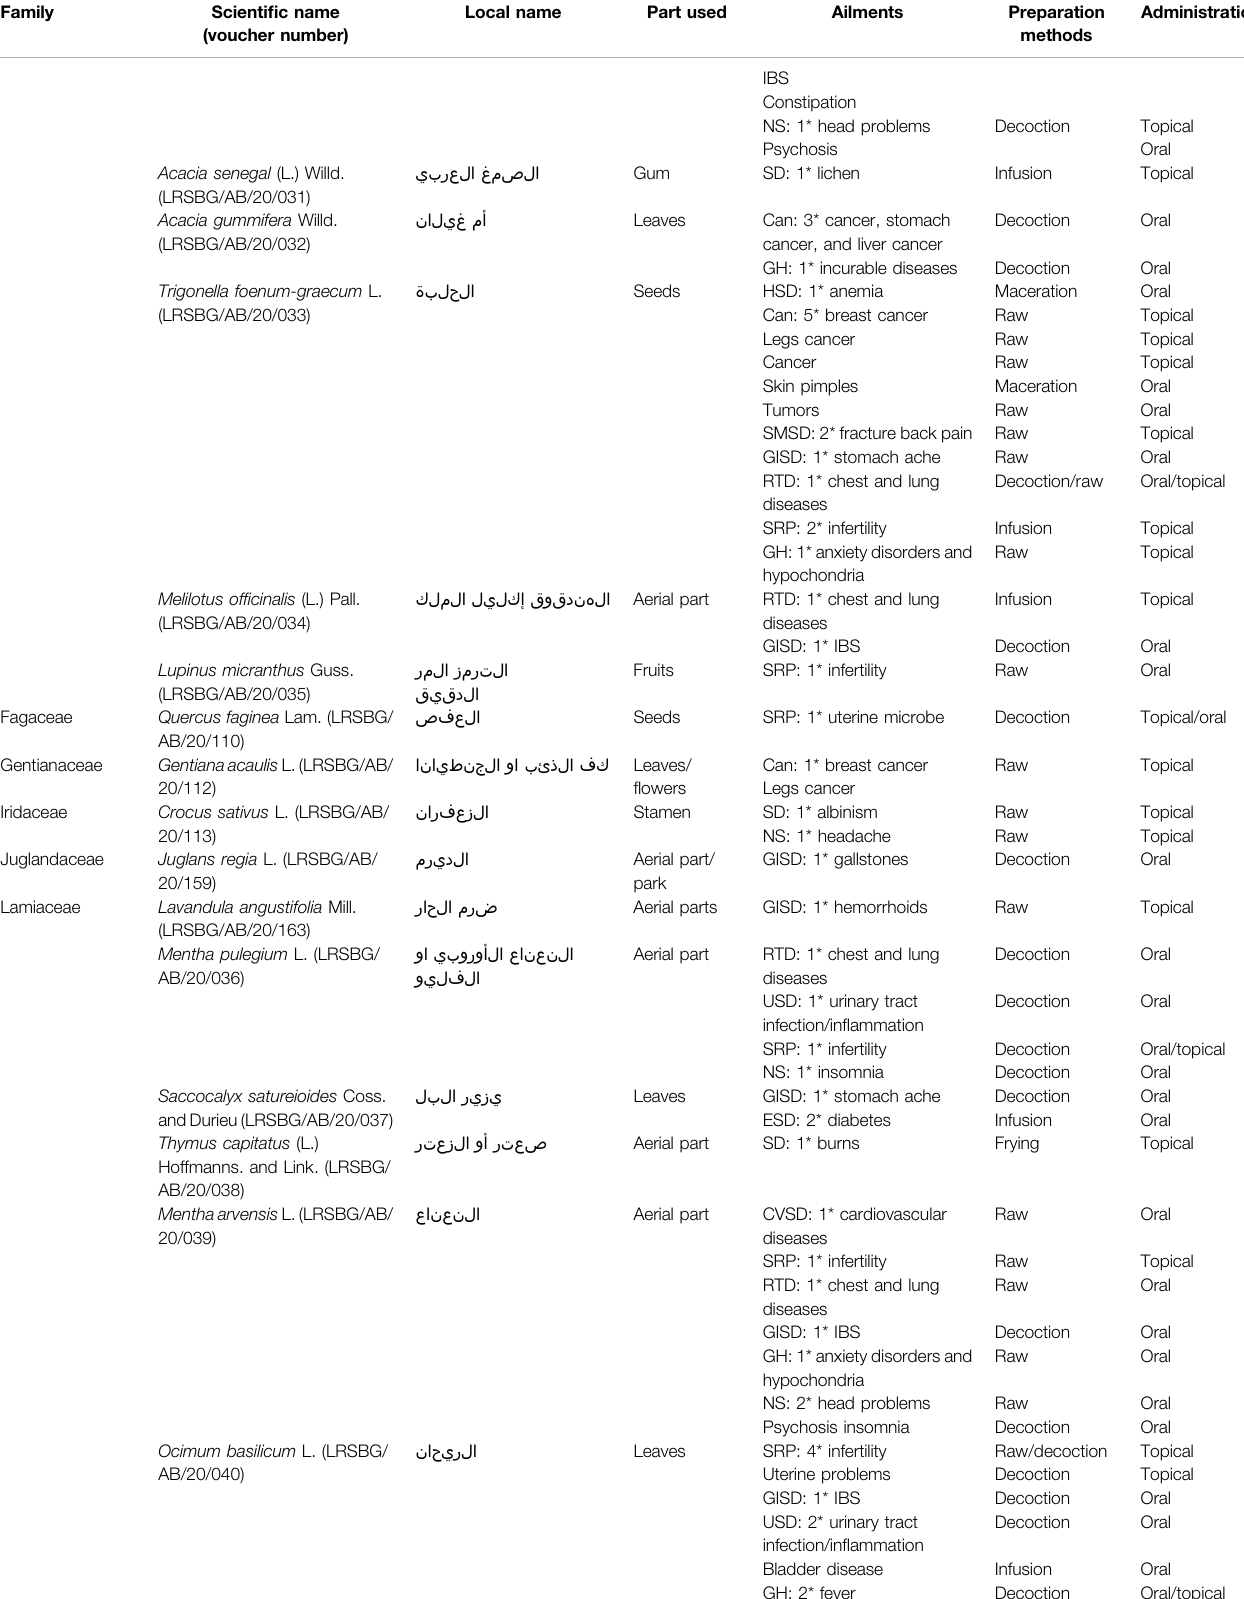
TABLE 7 | ( Continued ) List of medicinal plants used by traditional healers in the study